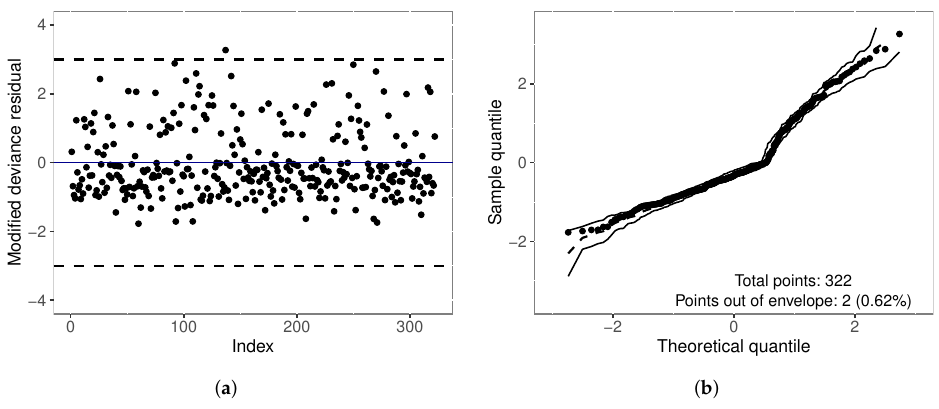
Figure 8. ( a ) Index plot of r D . ( b ) Normal probability plot for r D with envelope. i i The plots of the empirical and estimated survival functions for the two categorical variables in Figure 9 confirm the adequacy of the fitted